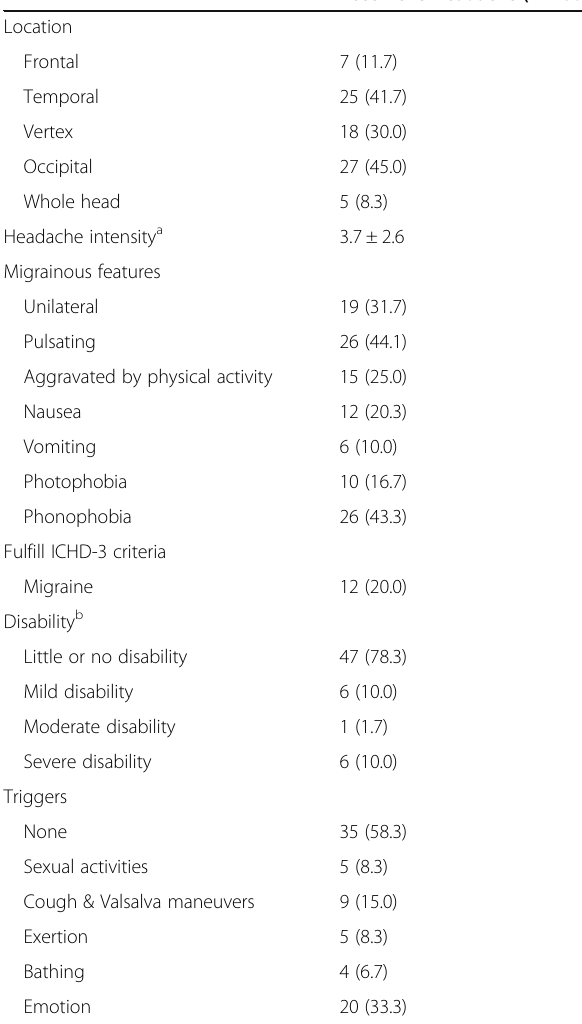
Table 2 Headache features of post-RCVS